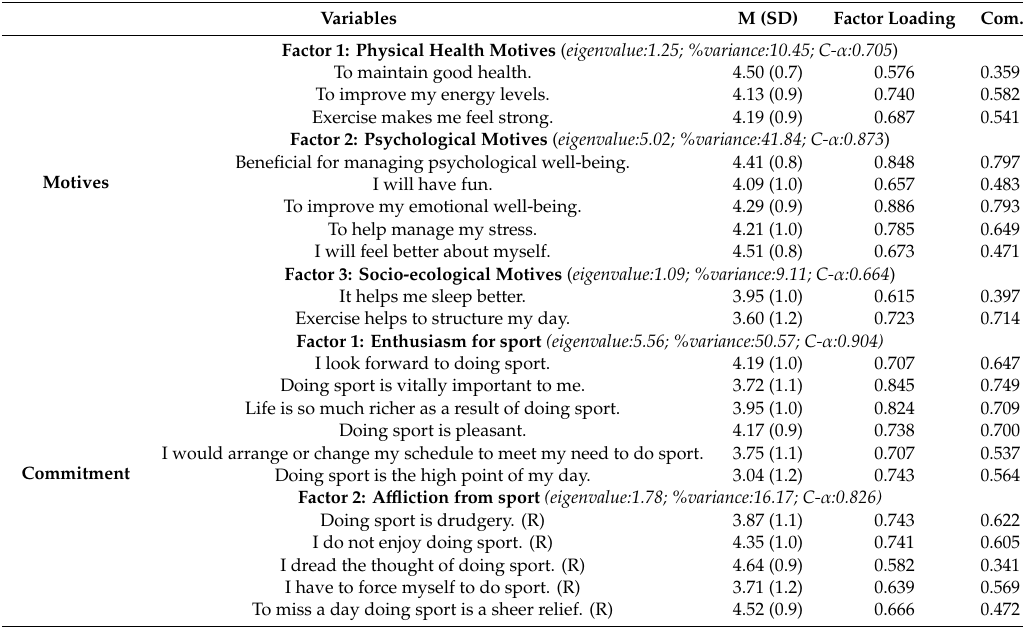
Table 2. Description of the EFA factors and results.